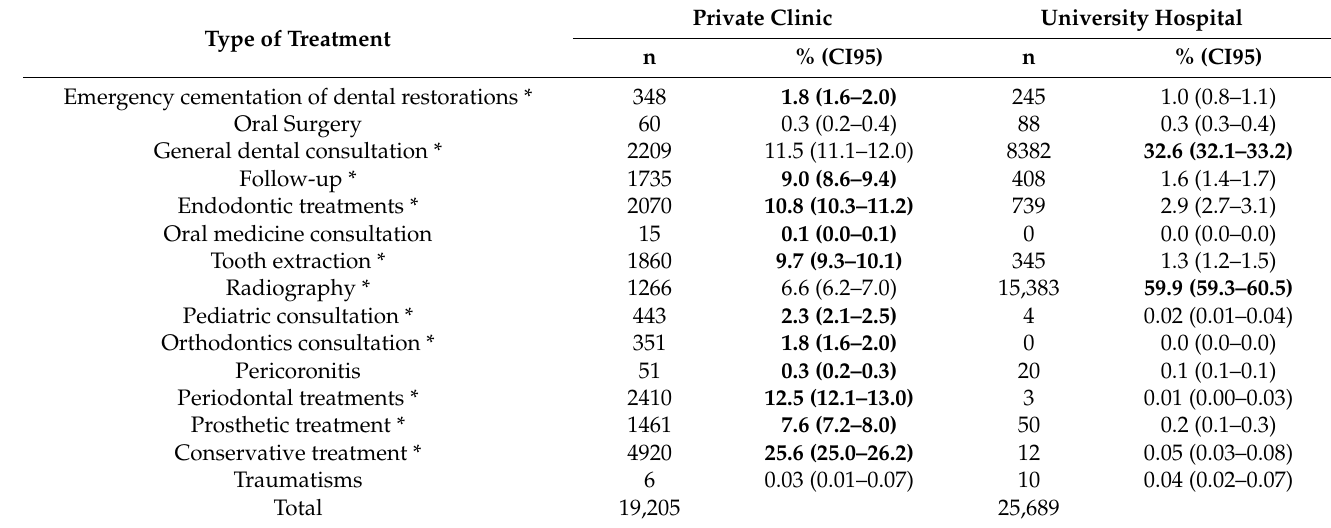
Table 3. Distribution of dental treatments performed in pre-pandemic period (March–June 2019) according to dental care center.